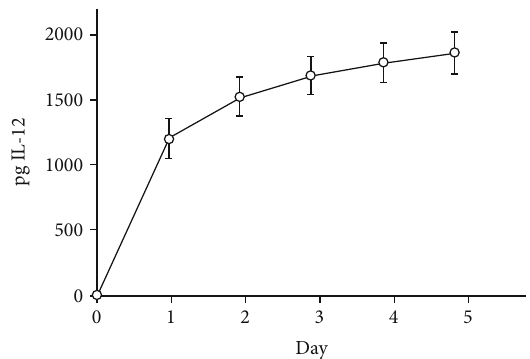
Figure 3: Cumulative amount of protein eluted over time from recombinant mouse IL-12-loaded poly(lactide-co-glycolic) acid (PLGA) nanospheres at a concentration of 500 million particles/ mL as measured by ELISA. Nanospheres were eluted in 500 μ L of release bu ff er (NRB; 10% heat-inactivated fetal bovine serum [HI- FBS] and 100units/mL Pen-Strep in DPBS) under constant agitation. Samples were collected from the supernatant following centrifugation of the pellet at 10000 × g for 15 minutes at 4 degrees